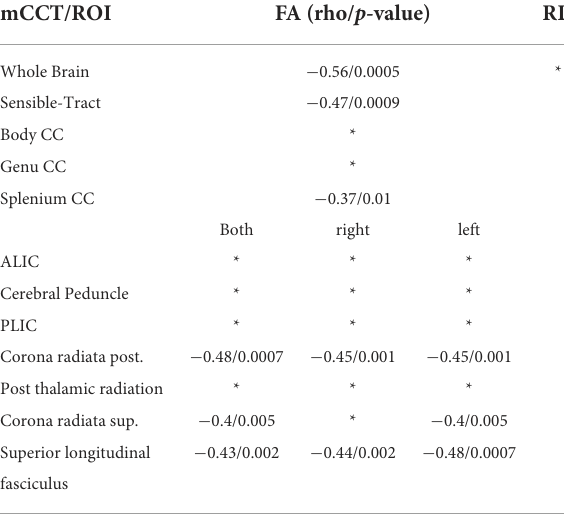
TABLE 3 Shown are the Spearman-Correlation values of N20-latencies from the right and left median nerve for selected ROIs and the DTI-derived parameter Radial Diffusivity (RD).